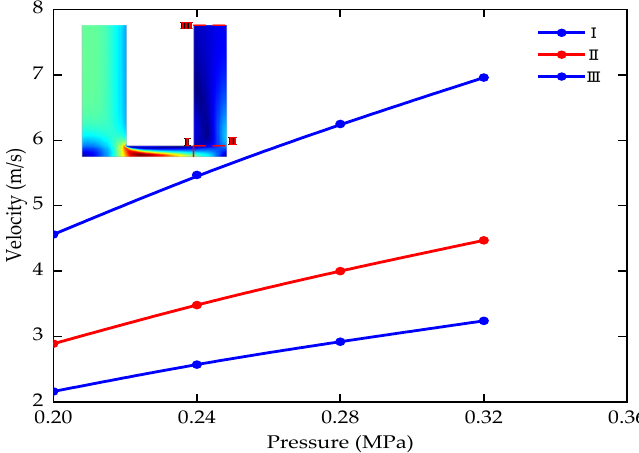
Figure 12. Electrolyte flow velocity with the different inlet pressure.